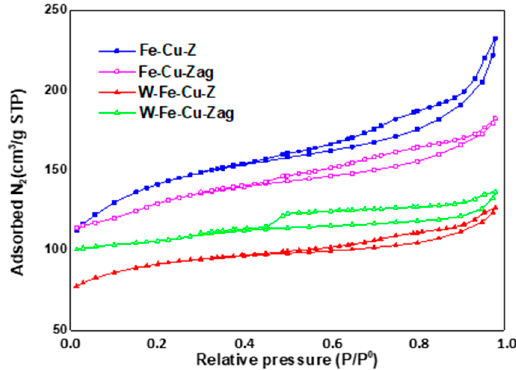
Figure 1. N 2 Adsorption ‒ desorption isotherms of fresh and steamed Fe-Cu-Z and